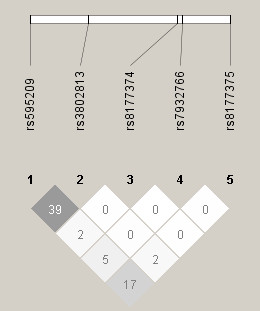
Linkage disequilibrium plot of five single nucleotide polymorphisms in TIRAP genotyped in the current study. We constructed the plot with the Haploview program [27], and r2 (×100) values were depicted in the diamonds. The color code on the plot follows the r2 scheme: r2 = 0, white; 0 < r2 < 1, shades of grey; r2 = 1, black.